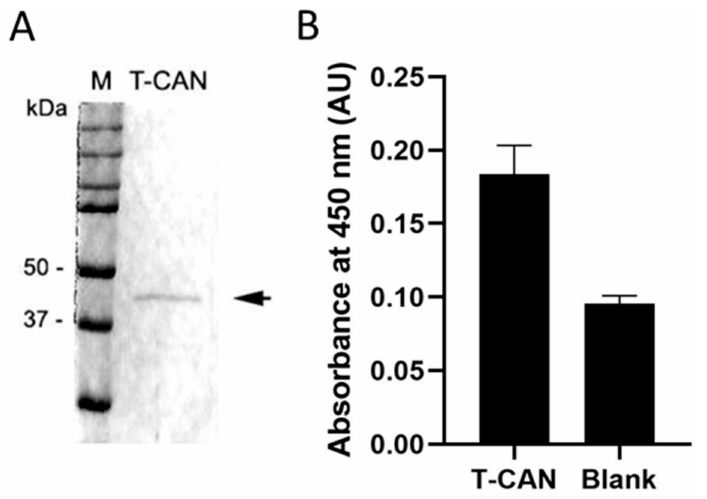
Figure 4. ( A ) The band of the T-CAN (expected MW: 42 kDa) is indicated by the arrow; ( B ) ELISA results of T-CAN binding to CD19.